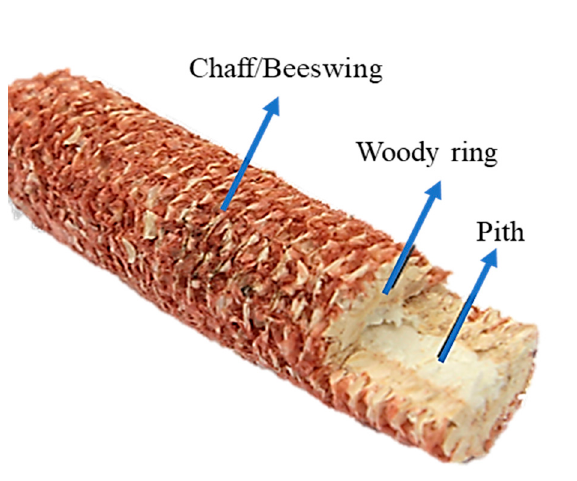
Figure 5. An image showing the structure of a corncob. Image adapted from Anonymous [22]. Fermentation 2020 , 6 , x FOR PEER REVIEW